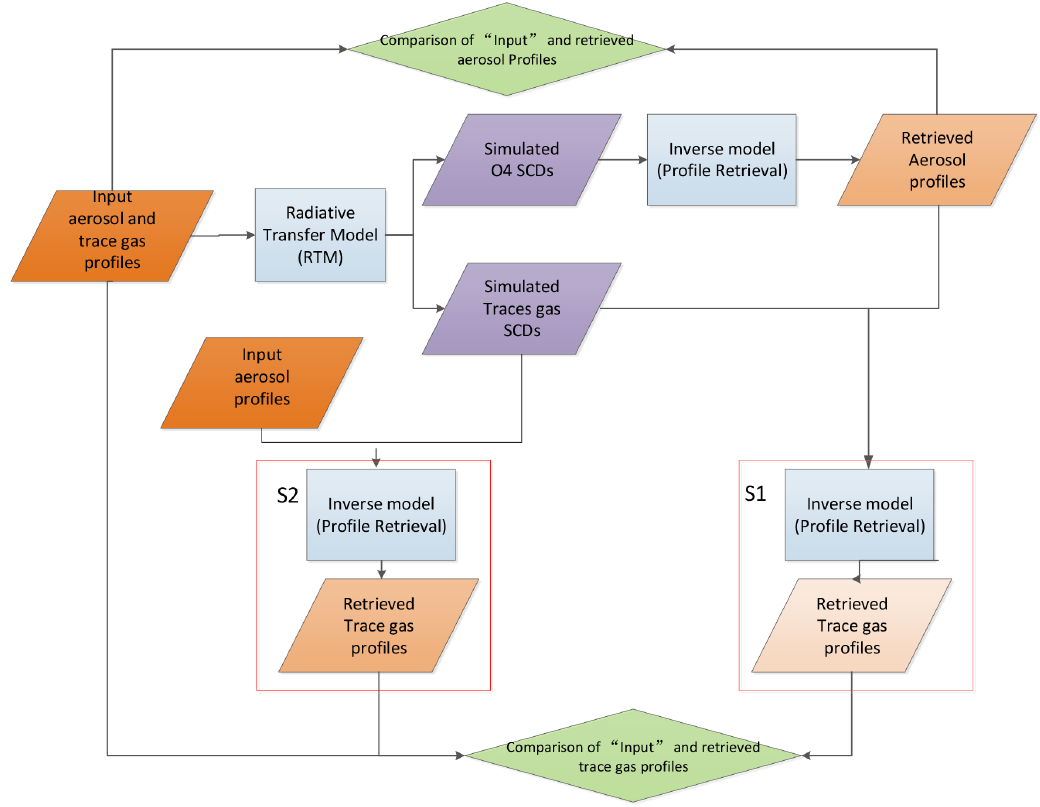
Figure 1. Flow diagram depicting the strategy used for the analysis of the effects of high aerosol loads on the retrieval of aerosol and trace gas profiles. Table 1. Parameter settings used in the RTM. Default values are indicated by ∗